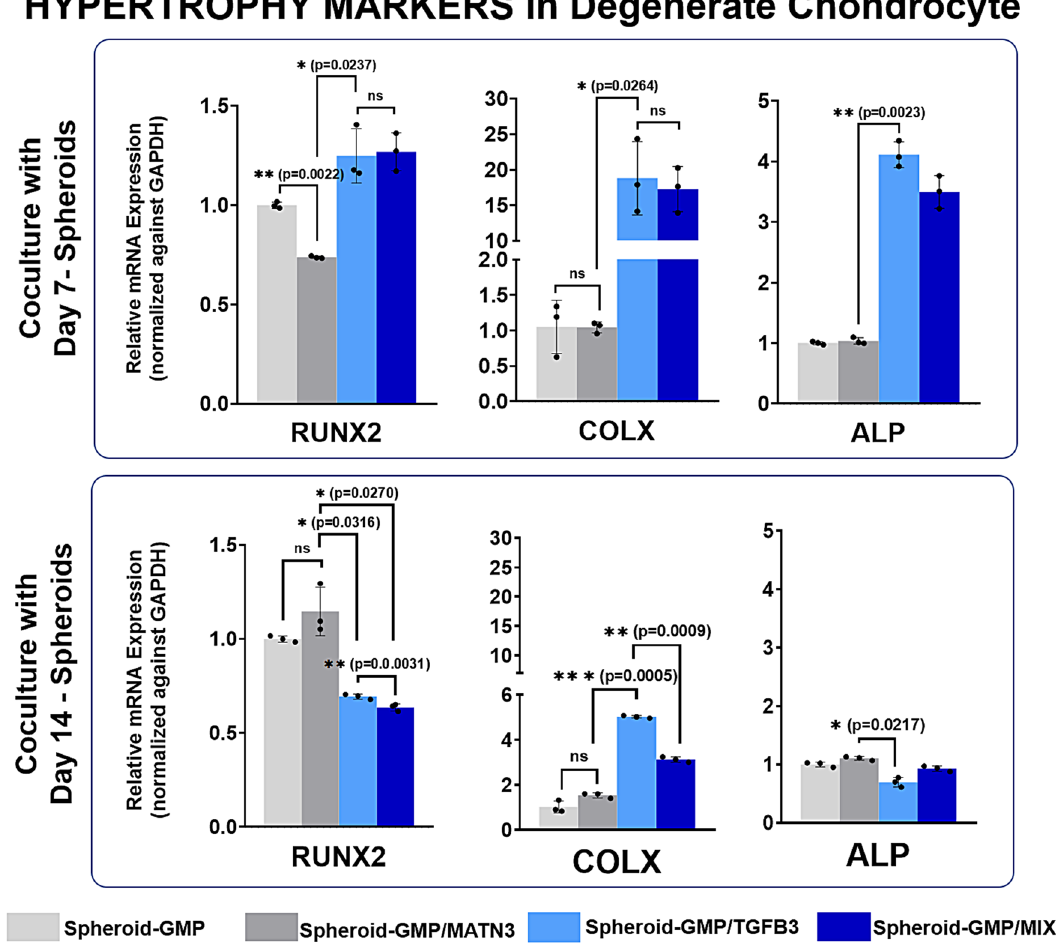
Fig. 9 Expression of hypertrophy markers in degenerated chondrocytes cocultured with D7 and D14 spheroids. Quantitative real-time gene expression analysis of the hypertrophy markers RUNX2, COLX, and ALP in degenerated chondrocytes cocultured with D7 and D14 spheroids. RT-PCR data were normalized against GAPDH expression. The data are representative of three independent experiments in triplicate. Error bars denote the means ± standard error of mean (sem) (ns = not signi fi cant, * p < 0.05, ** p < 0.01, *** p < 0.001; **** p < 0.0001). Individual data points and p-values for signi fi cance are indicated in the